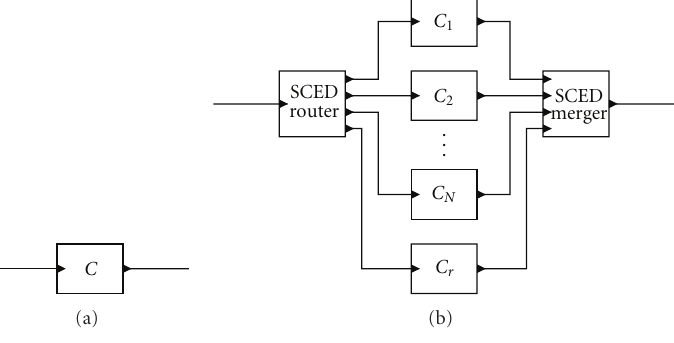
Figure 14: Semiconcurrent error detection at KPN